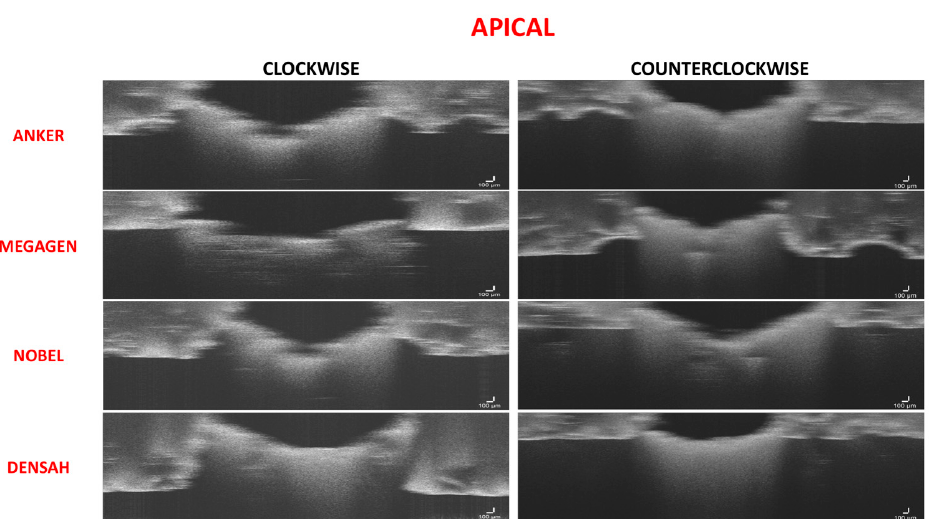
Figure 10. Figure composition showing representative samples of 2D sections at the apical region. Both groups showed slightly increased density at the apical area in clockwise rotation. The counter- clockwise drilling showed the highest bone density for all of the drill designs.